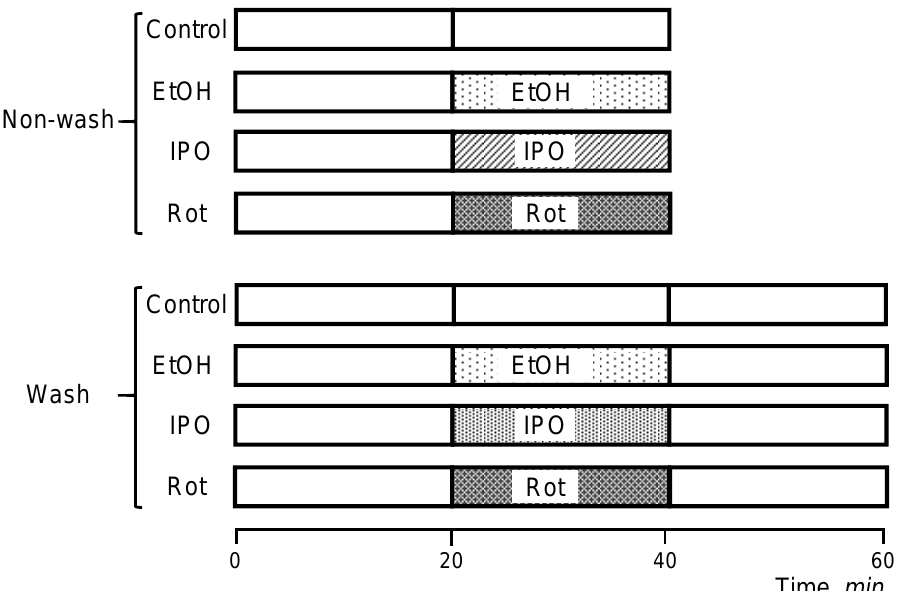
Figure 6. Scheme of experimental design. Rats were chosen randomly to participate in one of the following eight experimental groups: (1) control (no-treated group), 40-min perfusion ( n = 6), (2) ethanol (EtOH) group, 20-min perfusion with EtOH ( n = 8), (3) rotenone (Rot) group, 20-min perfusion with Rot ( n = 8), (4) isopropanol (IPO) group, 20-min infusion with IPO ( n = 6), (5) control (no-treated group), 60-min perfusion ( n = 6), (6) EtOH-wash group, 20-min perfusion with EtOH followed by a 20-min perfusion without EtOH ( n = 6), (7) Rot-wash group, 20-min perfusion with Rot followed by a 20-min perfusion without Rot ( n = 6), and (8) IPO-wash group, 20-min perfusion with IPO followed by a 20-min perfusion without IPO ( n = 6). Details are given in Materials and Methods .